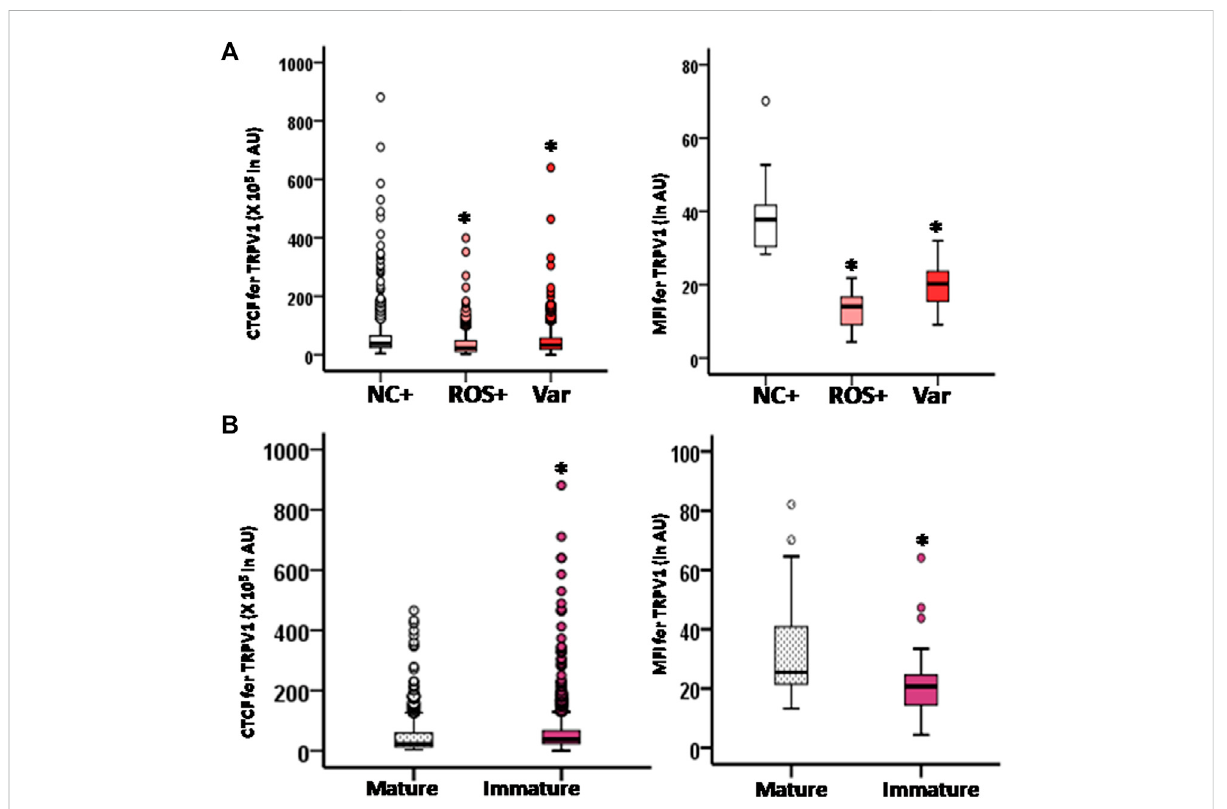
Box-whisker plot of corrected total cell fl uorescence (CTCF) intensity of TRPV1 in spermatozoa of different groups in arbitrary units (AU), and box-whiskerplotofmean fl uorescenceintensity(MFI)ofFACsanalysisshowingtheintensityofTRPV1inspermatozoaofdifferentgroupsinarbitrary units(AU).MFIdataareexpressedasgeometricmeaninlogarithmicscaleofcorrespondinghistogram. (A) Expressionpro fi leinspermatozoaoffertile donors (NC+), idiopathic infertile men with high ROS ( > 102.2 RLU/s/10 6 sperm) (ROS+) and infertile men presented with varicocele (Var+);